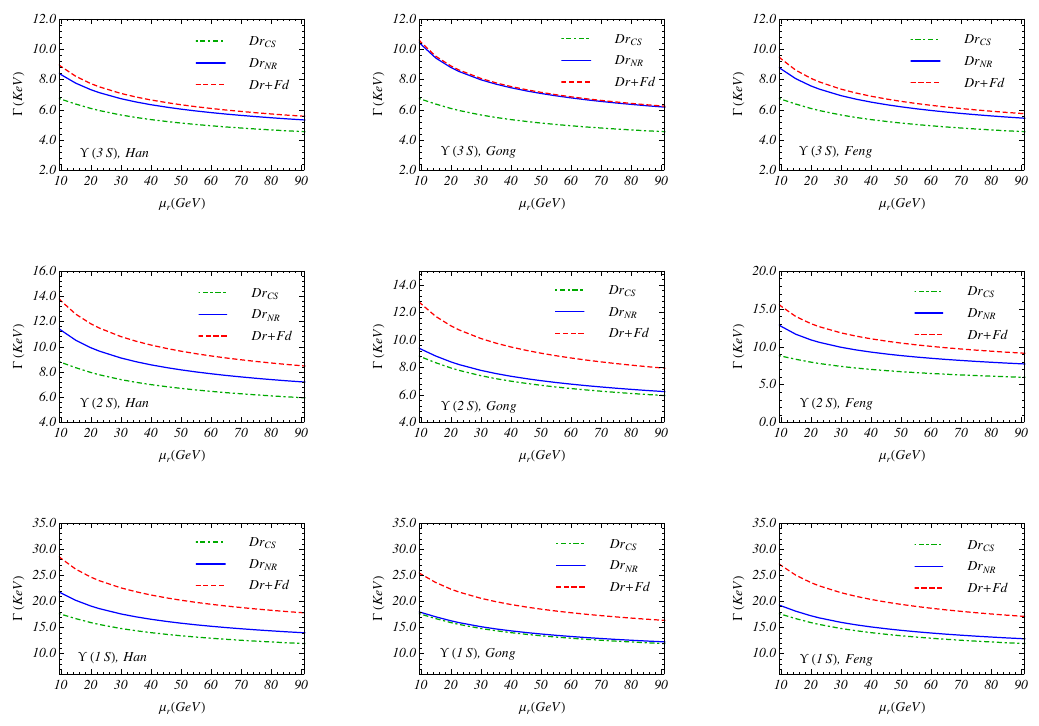
Figure 6 . Decay widths of Z → Υ( nS ) + X as a function of µ r , obtained by the LDMEs of refs. [34–36]. The subscript “ NR 00 means the sum of the CS and CO contributions. “ Dr 00 and “ Fd 00 refer to the direct-production processes and feed-down effects, respectively. m b = 4 . 75 GeV and µ r = m Z / 2